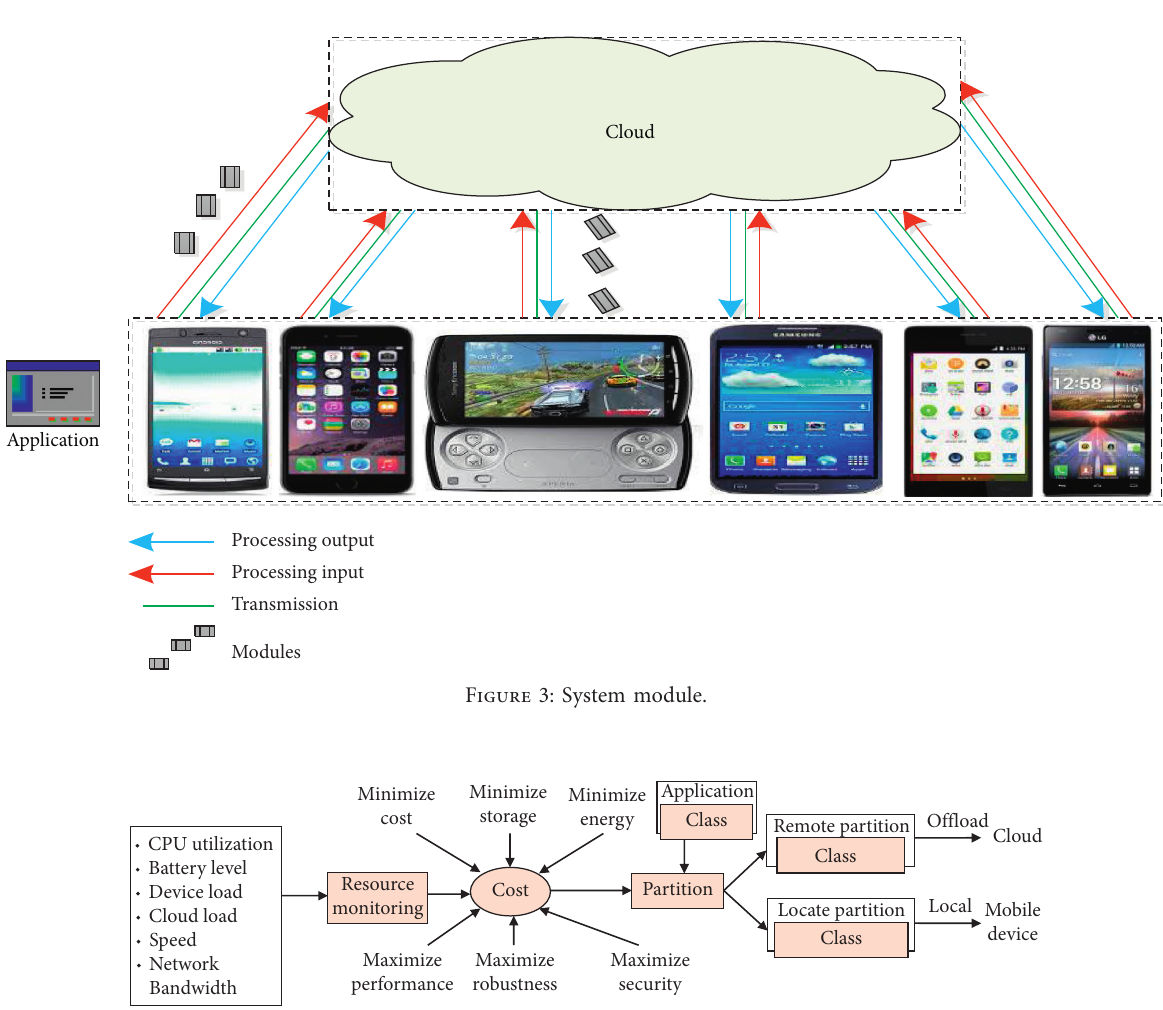
Figure 2: Taxonomy of MCC protocols.